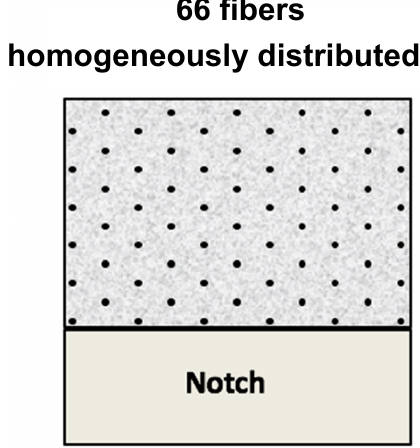
Figure 2. Cross-section of the specimens performed with a homogeneous distribution of fibers.